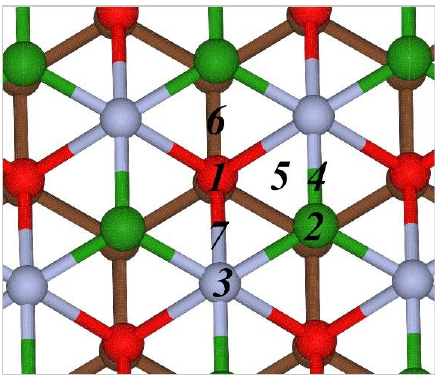
Figure 2. Different adsorption positions for metal atoms on the borophene side of the borophene- graphene bilayer structure are numbered as 1 ÷ 7. Brown atoms and bonds represent underlying graphene. Red, green, and beige balls represent boron atoms in different non-equivalent positions.